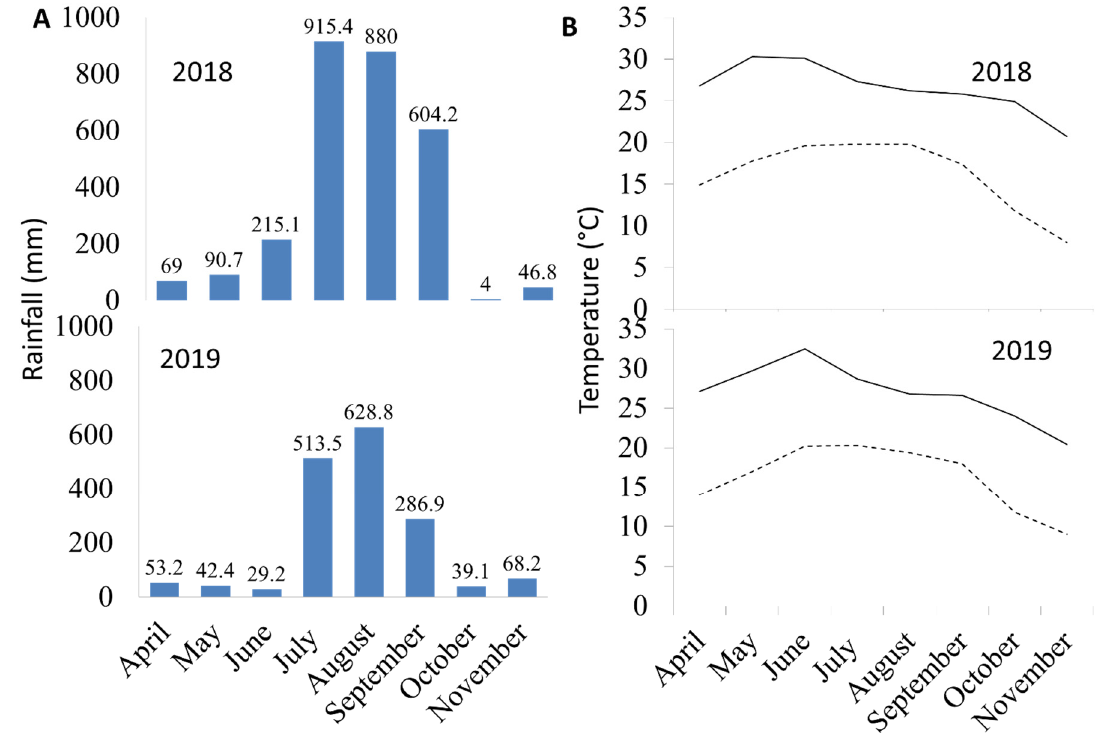
Figure 1. Monthly rainfall ( A ) and maximum (—) and minimum ( − − ) temperature; ( B ) during the two growing seasons (2018 and 2019).